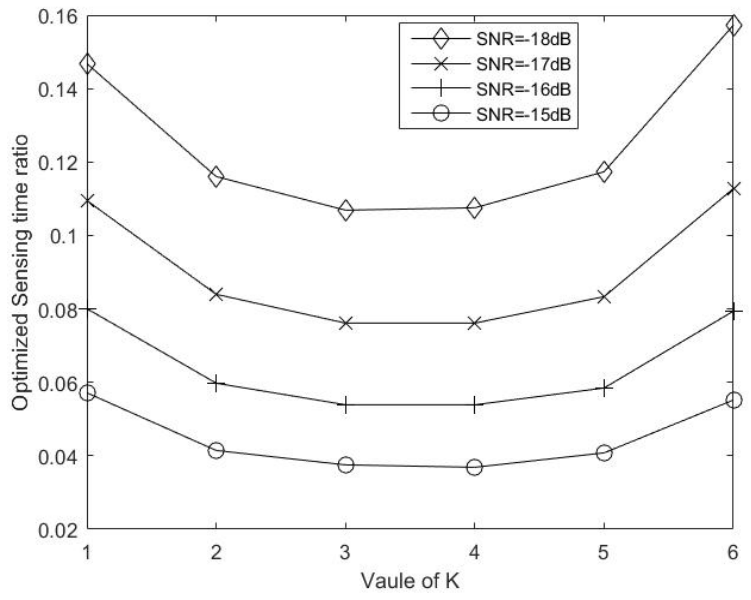
Figure 7. Optimized sensing ratio under different fusion rules.